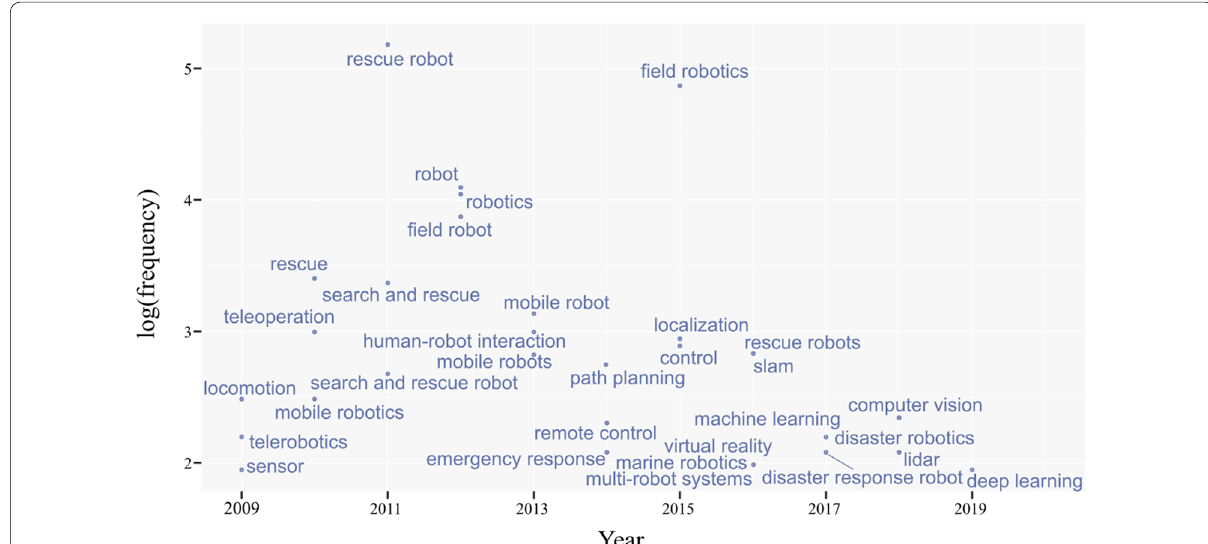
Fig. 9 A timestamped keyword analysis in RR for the last decade. In this analysis, the top 3 frequent keywords are selected which have been mentioned at least 7 times in the literature during a